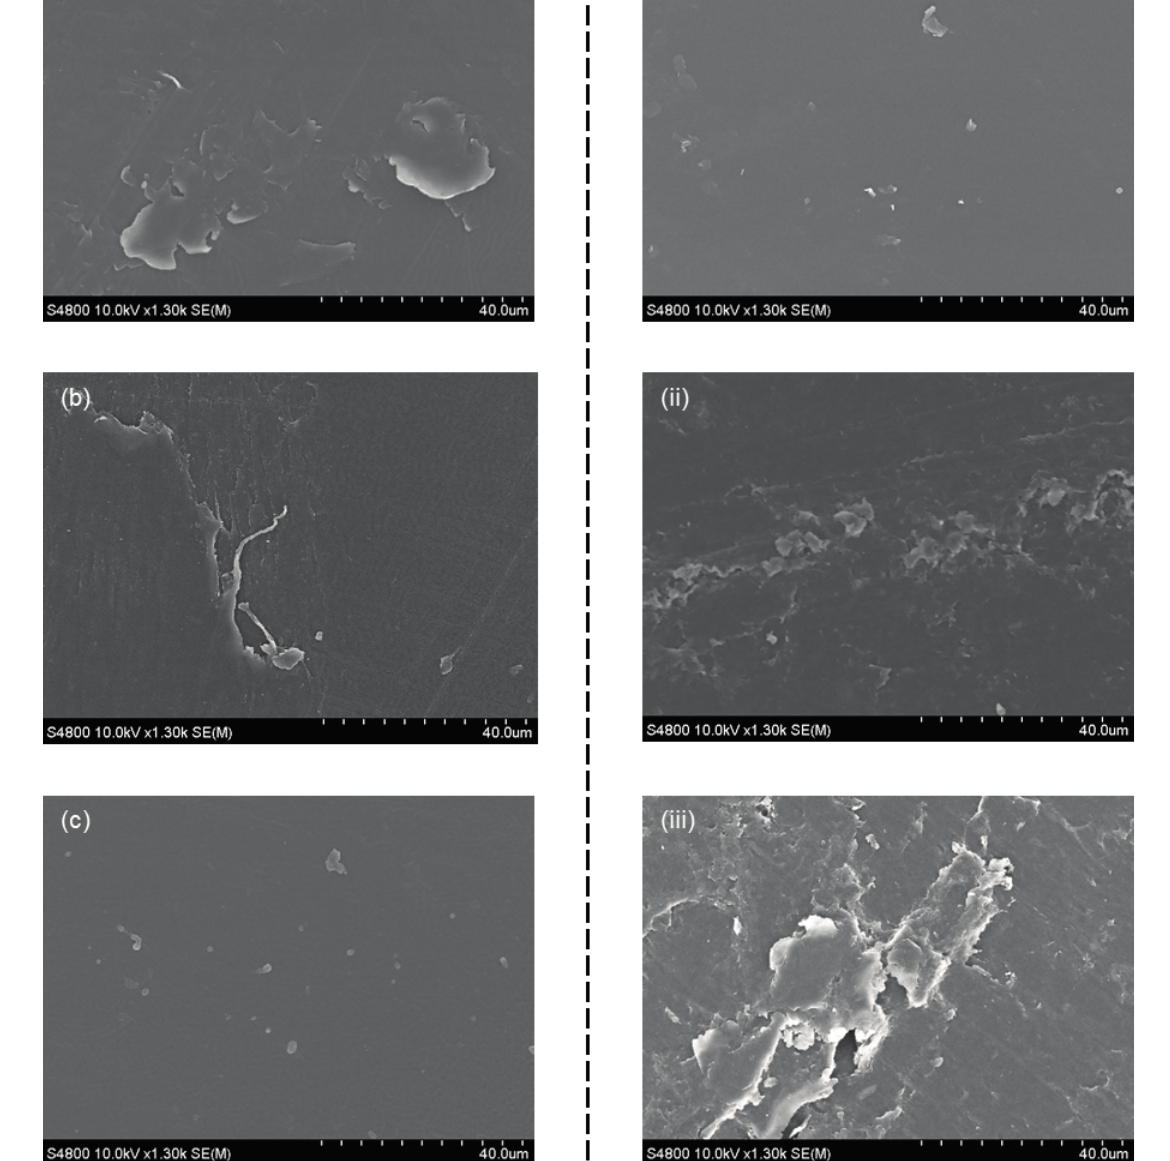
Figure 7. Surface morphology of films containing. Effects of increasing concentration of glycerol used as a plasticizer ( left ) and increasing concentration of β -galactosidase ( right ). Left : ( a ) 10% glycerol; ( b ) 14%; and ( c ) 20%. Right : ( i ) 3.5% β -galactosidase; ( ii ) 8%; and ( iii )